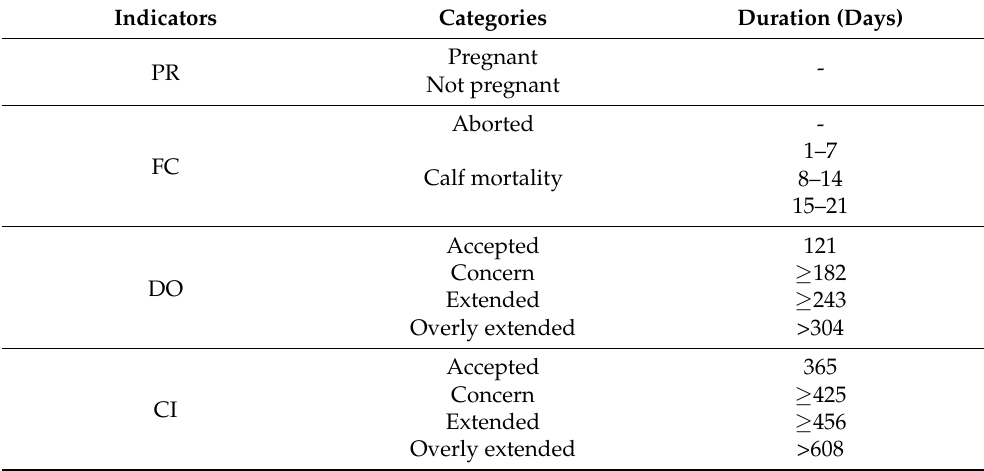
Table 1. Categories of reproductive performance